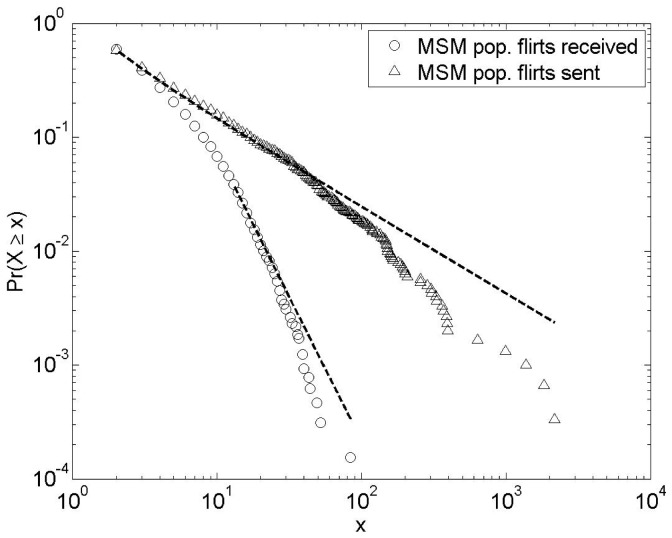
Cumulative degree distribution of the flirt messages received (N = 21,687;circles) and flirt messages sent (N = 33,865 ;triangles) by the MSM population during the study period.
Lines indicate the best fitting power law model.